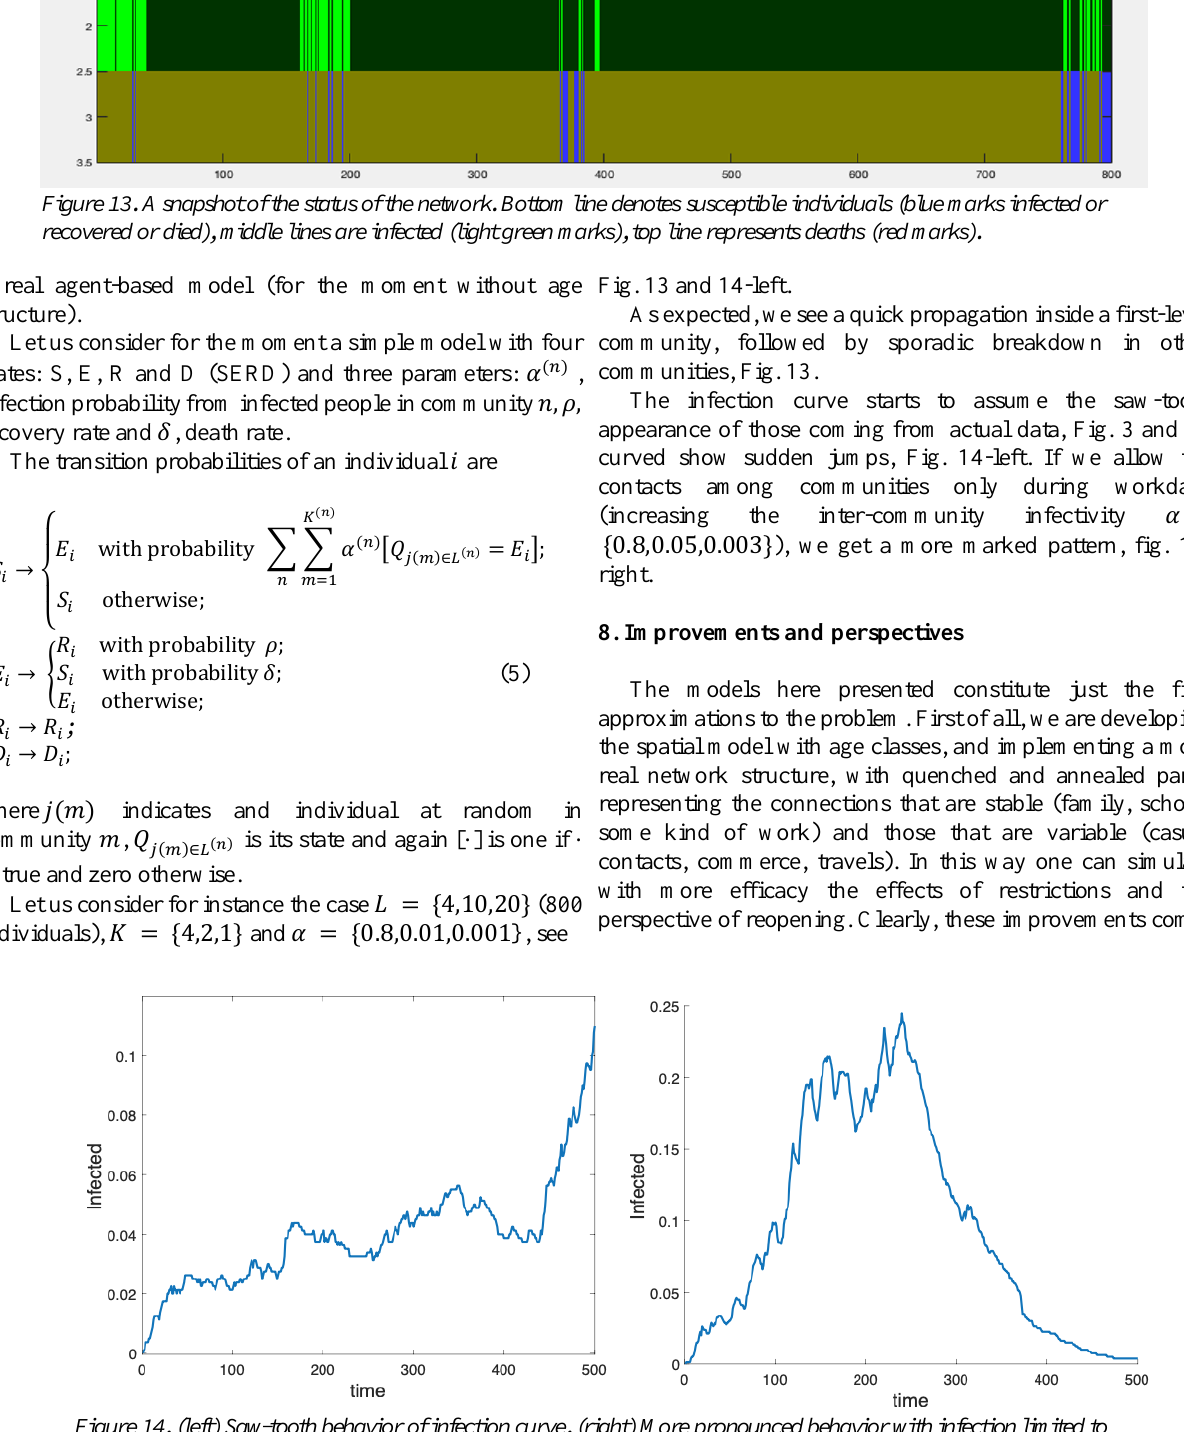
Figure 14. (left) Saw-tooth behavior of infection curve. (right) More pronounced behavior with infection limited to